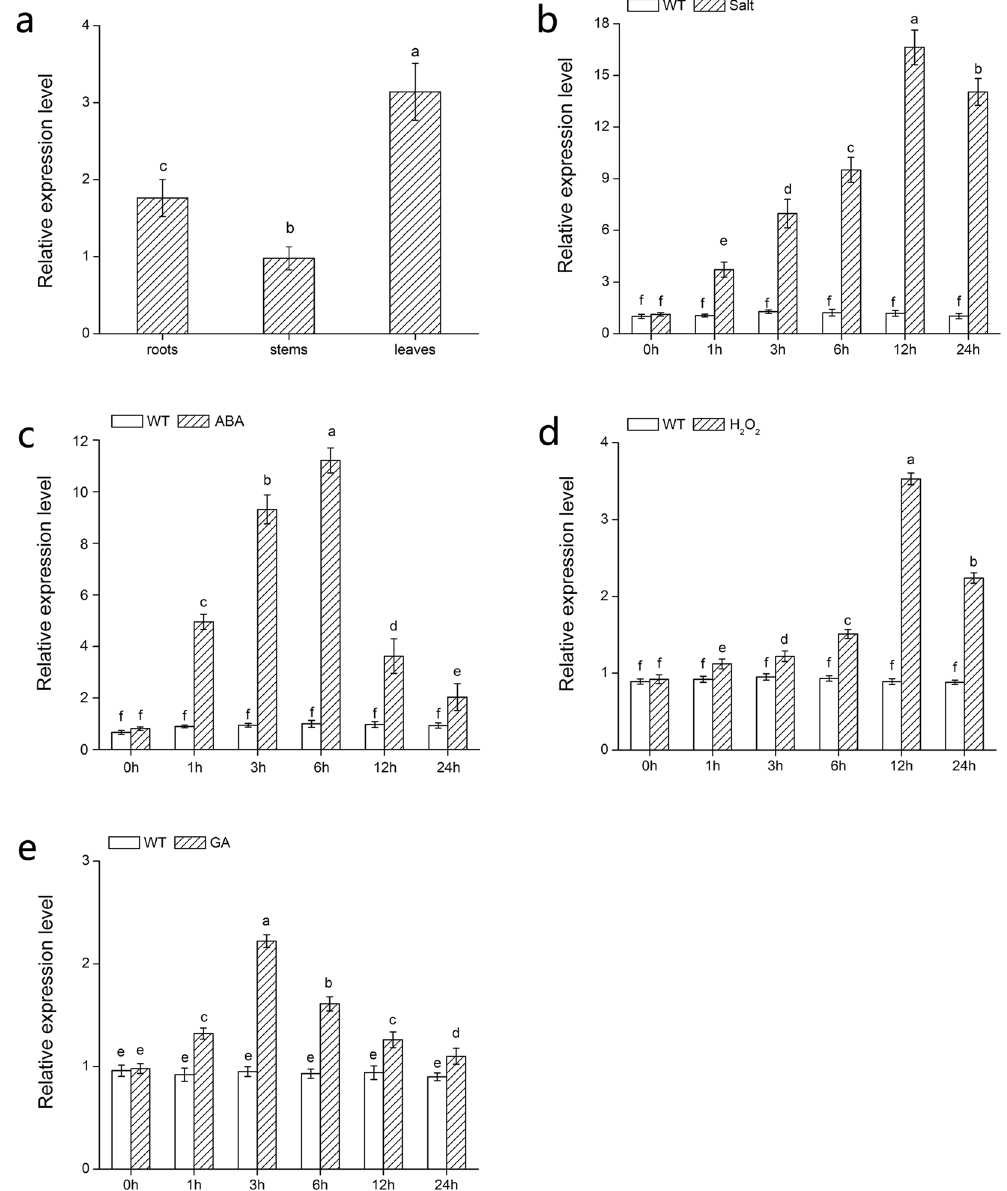
Figure 1. Analysis of DgWRKY5 expression in different tissues and in response to various treatments. ( a ) Expression patterns of DgWRKY5 in roots, stems and leaves. ( b ) Salt. ( c ) ABA. ( d ) H 2 O 2 . ( e ) GA. Data represent means and standard errors of three replicates. Different letters above the columns indicate significant differences (P < 0.05) on the basis of Duncan’s multiple range